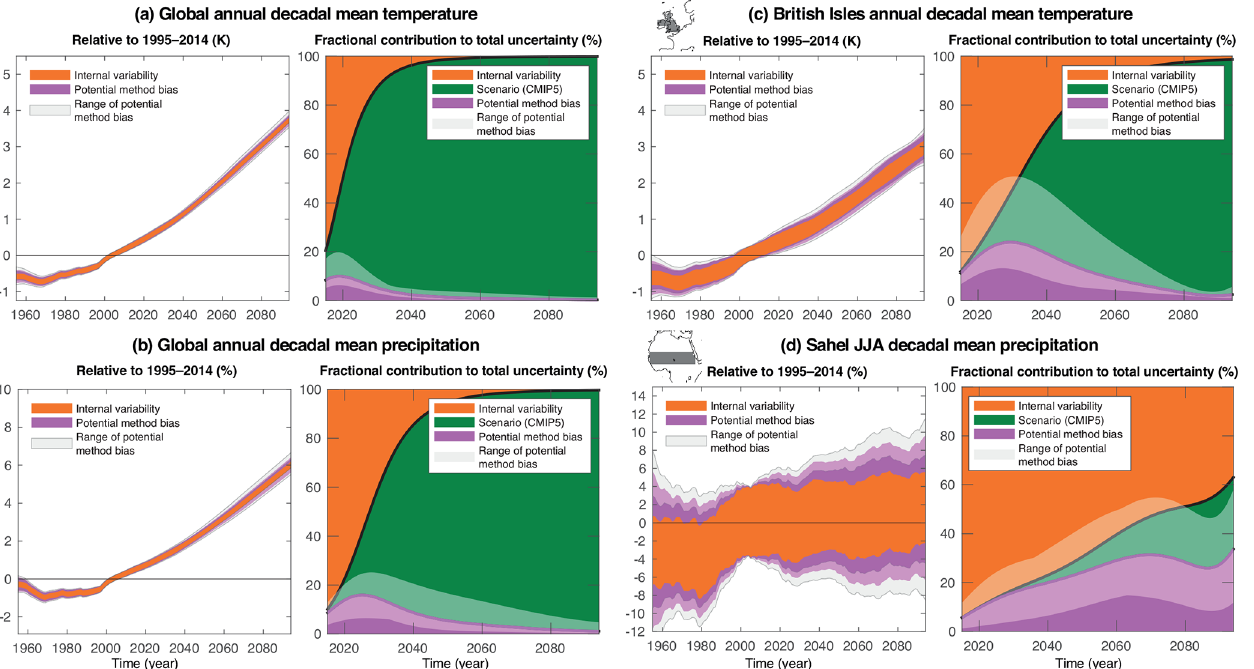
Figure 5. Decadal mean projections from SMILEs and fractional contribution to total uncertainty (using scenario uncertainty from CMIP5) for (a) global mean annual temperature, (b) global mean annual precipitation, (c) British Isles annual temperature and (d) Sahel June–August precipitation. The pink color indicates the potential method bias and is calculated the same way as model uncertainty in the HS09 approach, except instead of different models we only use different ensemble members from a SMILE; thus if the HS09 method were perfect, the bias would be zero. This potential method bias is calculated using each SMILE in turn, and then the mean value from the seven SMILEs is used for the dark pink curve, while the slightly transparent white shading around the pink curve is the range of the potential method bias based on different